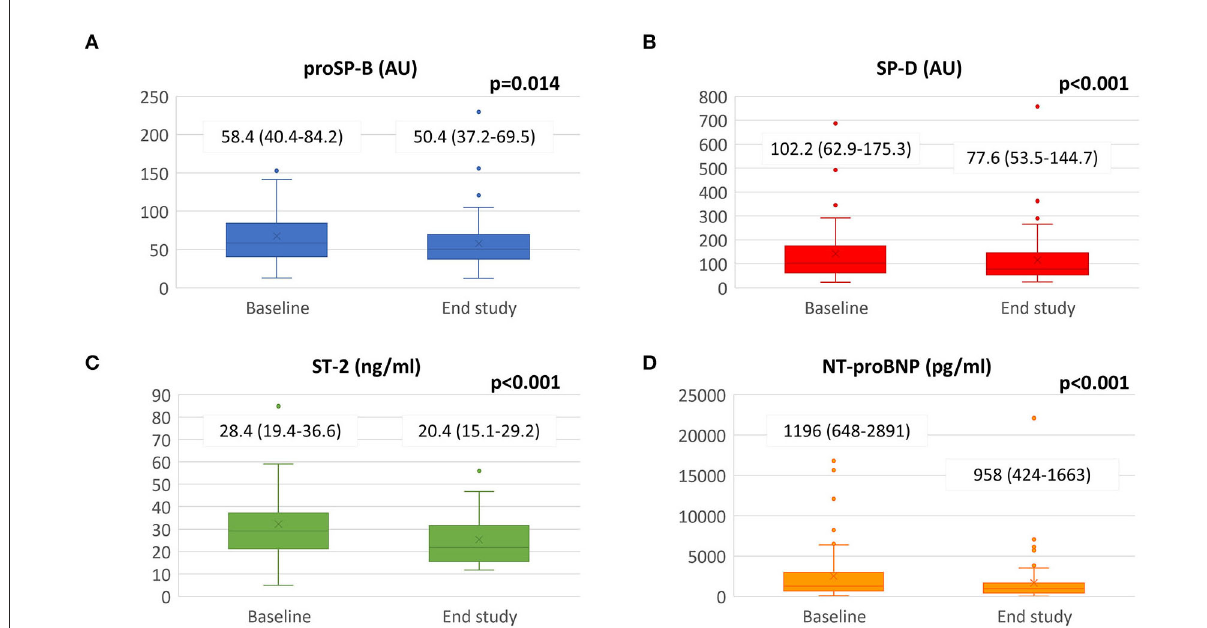
FIGURE1 Biomarkers changes from baseline to the end of the study. Sacubitril/Valsartan significantly reduced panel (A) SP-B, panel (B) SP-D, panel (C) ST-2 and panel (D) NT-proBNP value after a median follow-up of 8.7 ± 1.4 months. Data presented as medians and interquartile ranges. proSP-B: immature form of surfactant protein isoform B; SP-D: surfactant protein isoform D; NT-proBNP: amino terminal pro-B-type natriuretic peptide; ST-2: interleukin ST-2.